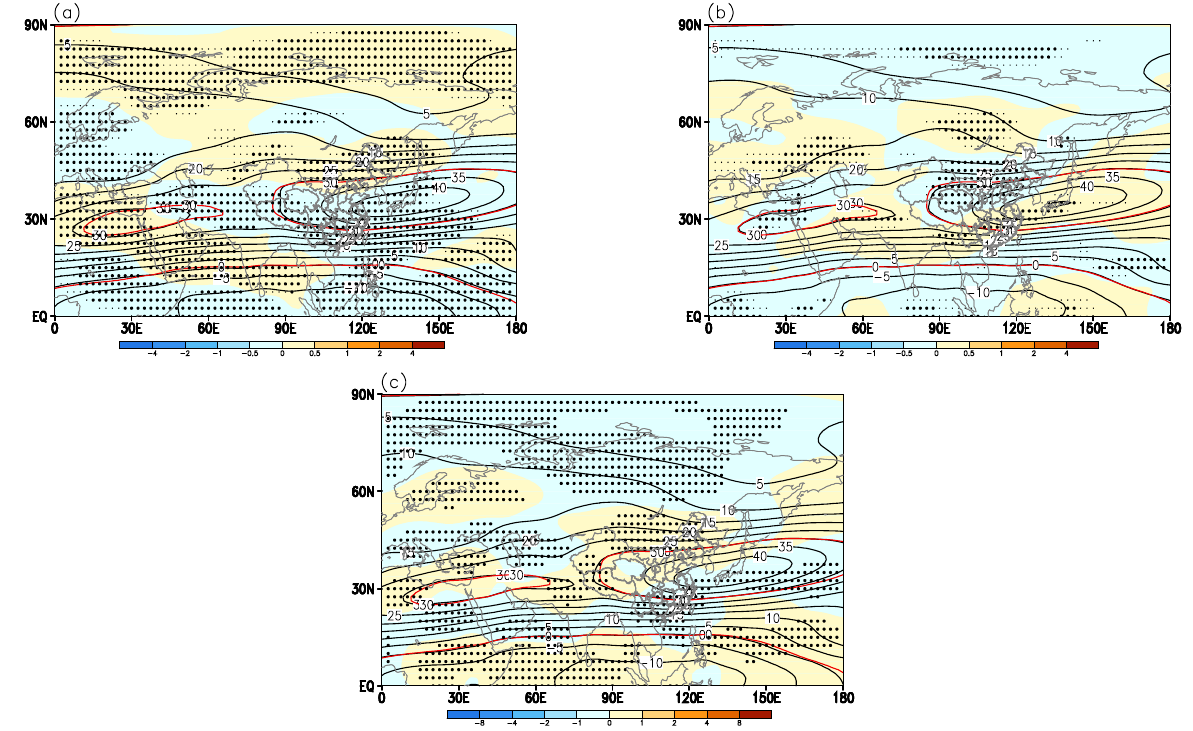
Figure 6. Same as Figure 5, ( a ) 1961–1992, ( b ) 1993–2002 and ( c ) 2003–2020 over the Dongting Lake basin. but for 200-hPa zonal wind (contours, unit: m·s − 1 ), where the red solid lines represent the climatology of wind speed isolines of 0 m·s − 1 and 30 m·s − 1 from 1981 to 2010.